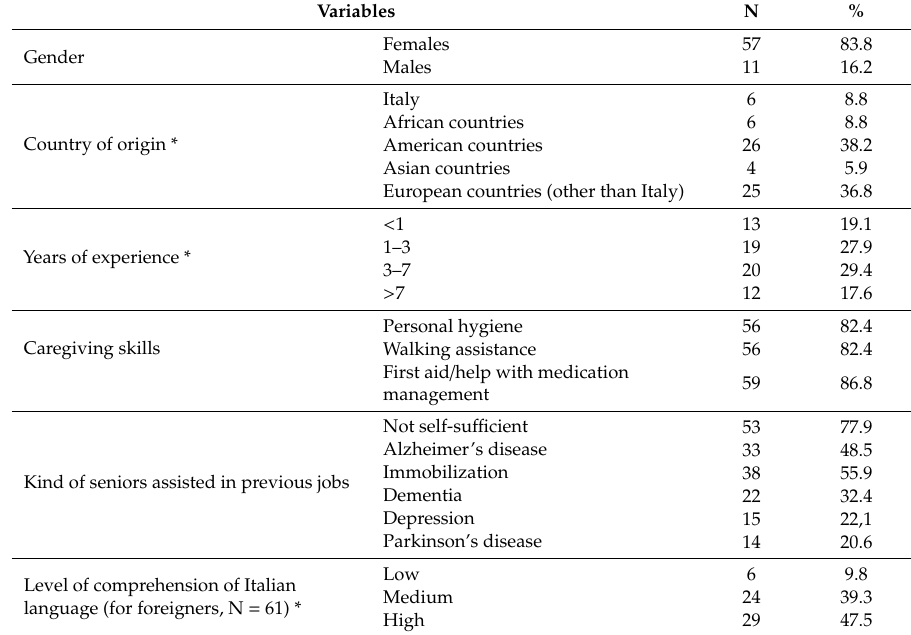
Table 3. The sample recruited during the job interview: descriptive analysis (N =